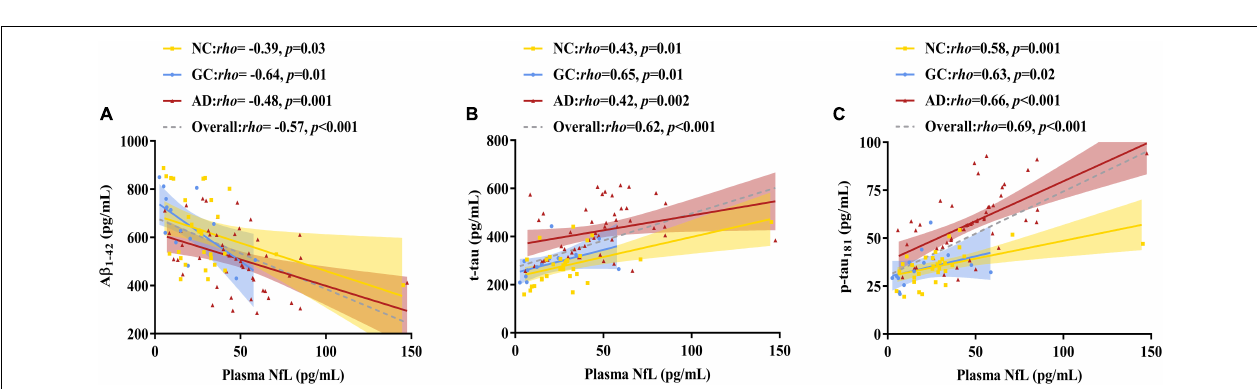
FIGURE 2 | Correlations of plasma NfL levels with age, MMSE scores and MoCA scores. (A) Relationship between plasma NfL and age. (B) Relationship between plasma NfL and MMSE. (C) Relationship between plasma NfL and MoCA. Pearson’s correlation tests were employed. The numbers are the Pearson correlation coefficients. The symbol “n.s.” indicates no significant association. NfL, neurofilament light chain; MMSE, Mini-Mental State Examination; MoCA, Montreal Cognitive Assessment; NC, normal control; GC, gastric cancer; AD, Alzheimer’s disease.